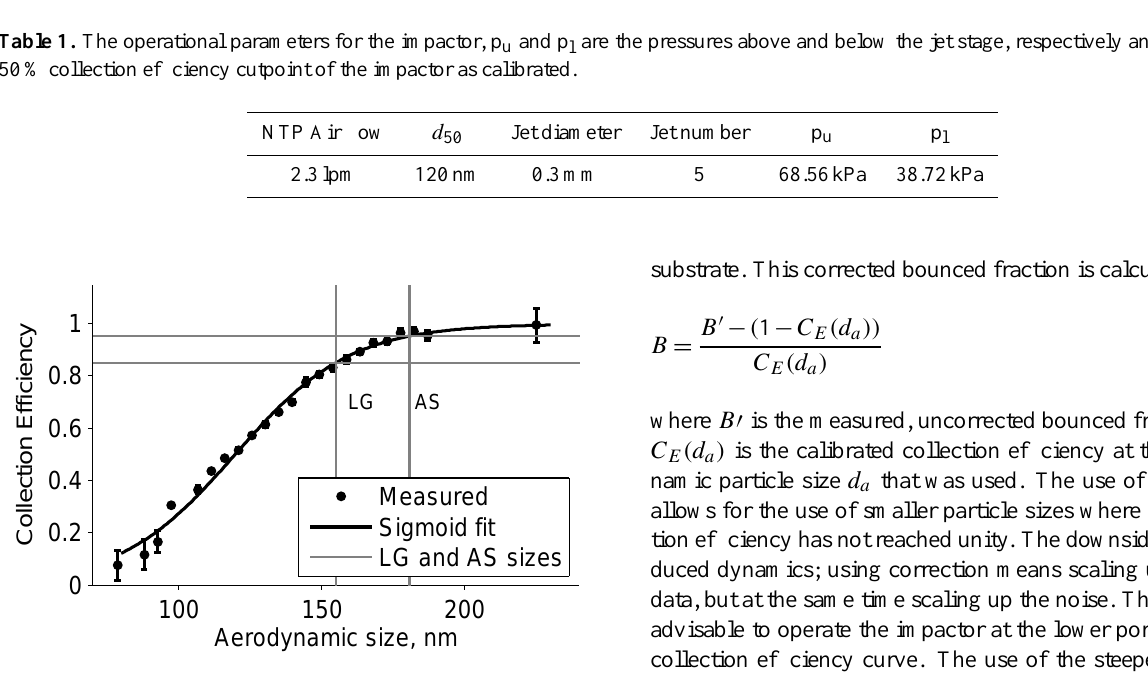
Fig. 2. The collection efficiency curve and sigmoid fit for the im- pactor stage used. Marked are the aerodynamic sizes and corre- sponding collection efficiencies for levoglucosan (LG) and ammo- nium sulfate